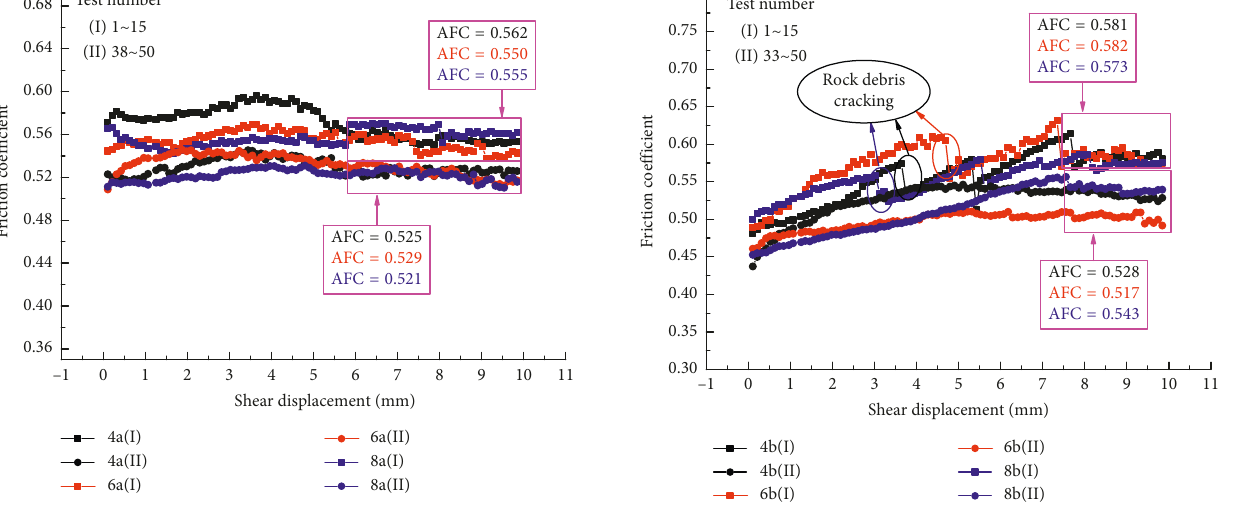
Figure 9: Direct shear testing results for the debris dry friction